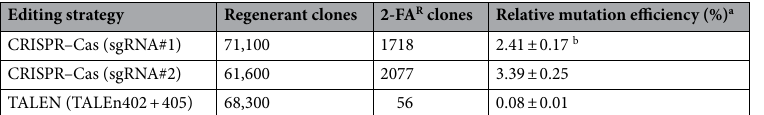
Table 1. Mutation rates of the APT gene using the CRISPR–Cas and TALEN systems. a Relative mutation efficiency expresses the frequency of 2-FA resistant clones among the population of regenerants. b Average and standard deviations were determined from three independent